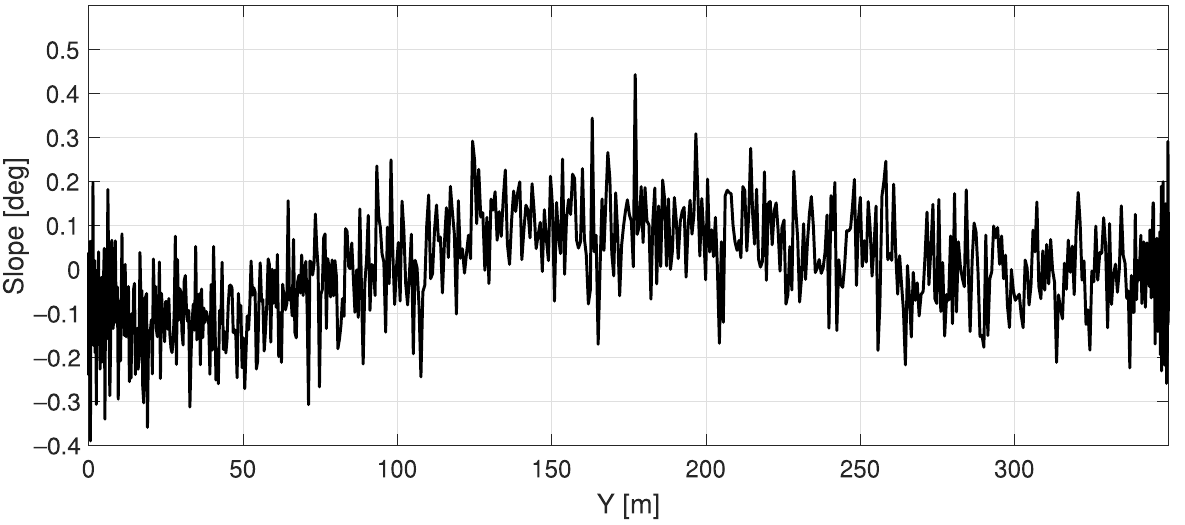
Figure 14. Comparison of the position error and heading angle error obtained through WO and IMU trajectory reconstruc- tion and slip prediction method.